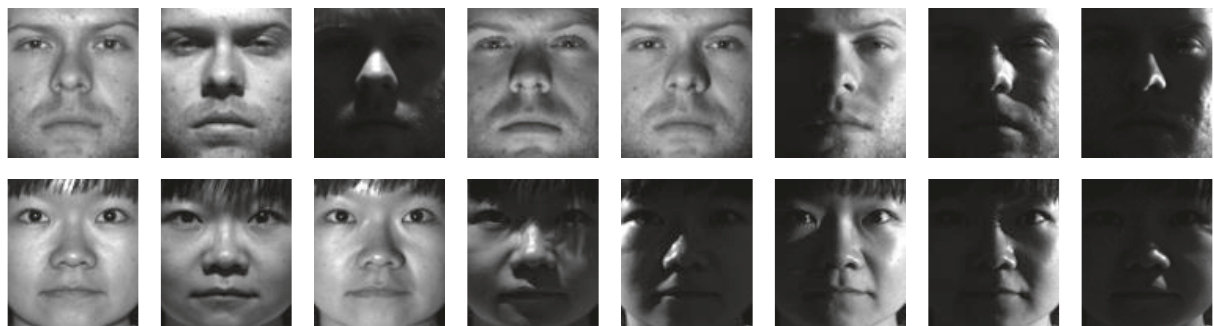
Figure 5: Some face images from the YaleB face database.